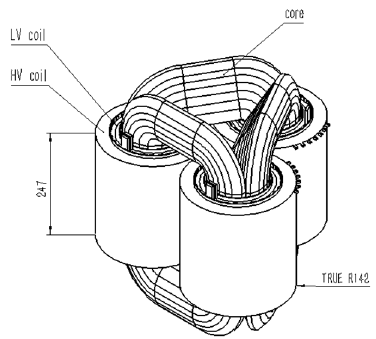
Figure 3. Core and coil structure of three-dimensional wound core transformer.